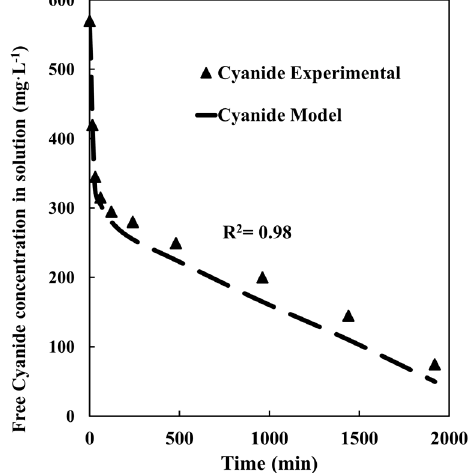
Figure 6. Free cyanide concentrations in solution for the pyrite + chalcopyrite leaching system.